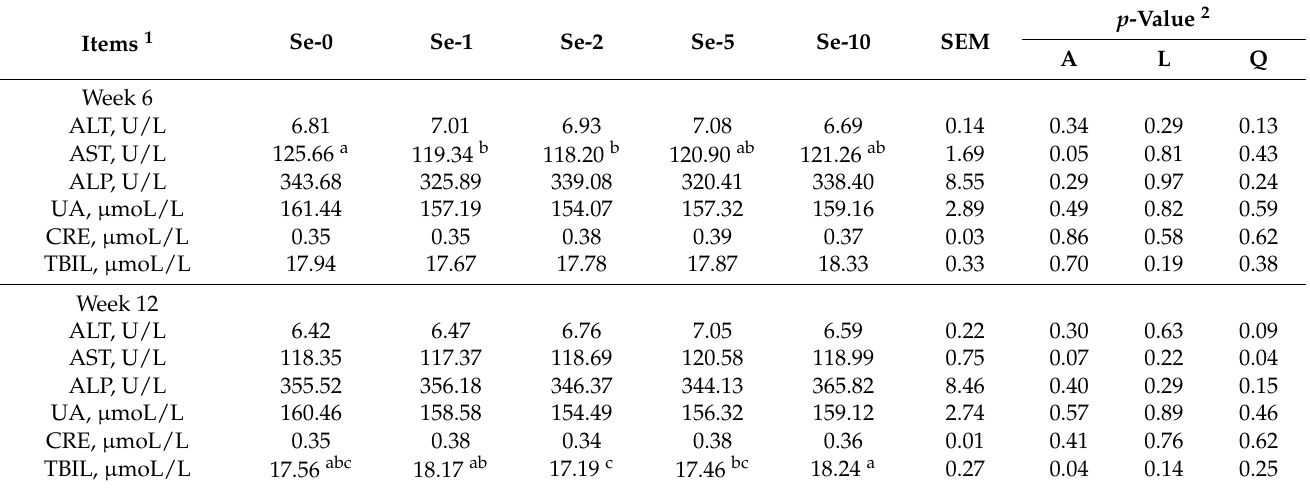
Table 6. Effects of dietary organic selenium on the blood biochemical indicators of laying hens.